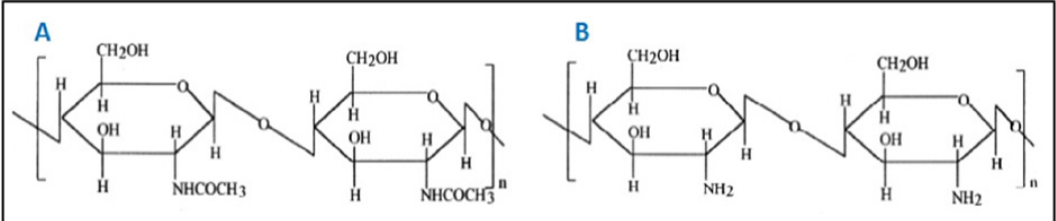
Fig. 1. Chemical structure of chitin (A) and chitosan (B) [65]. 2